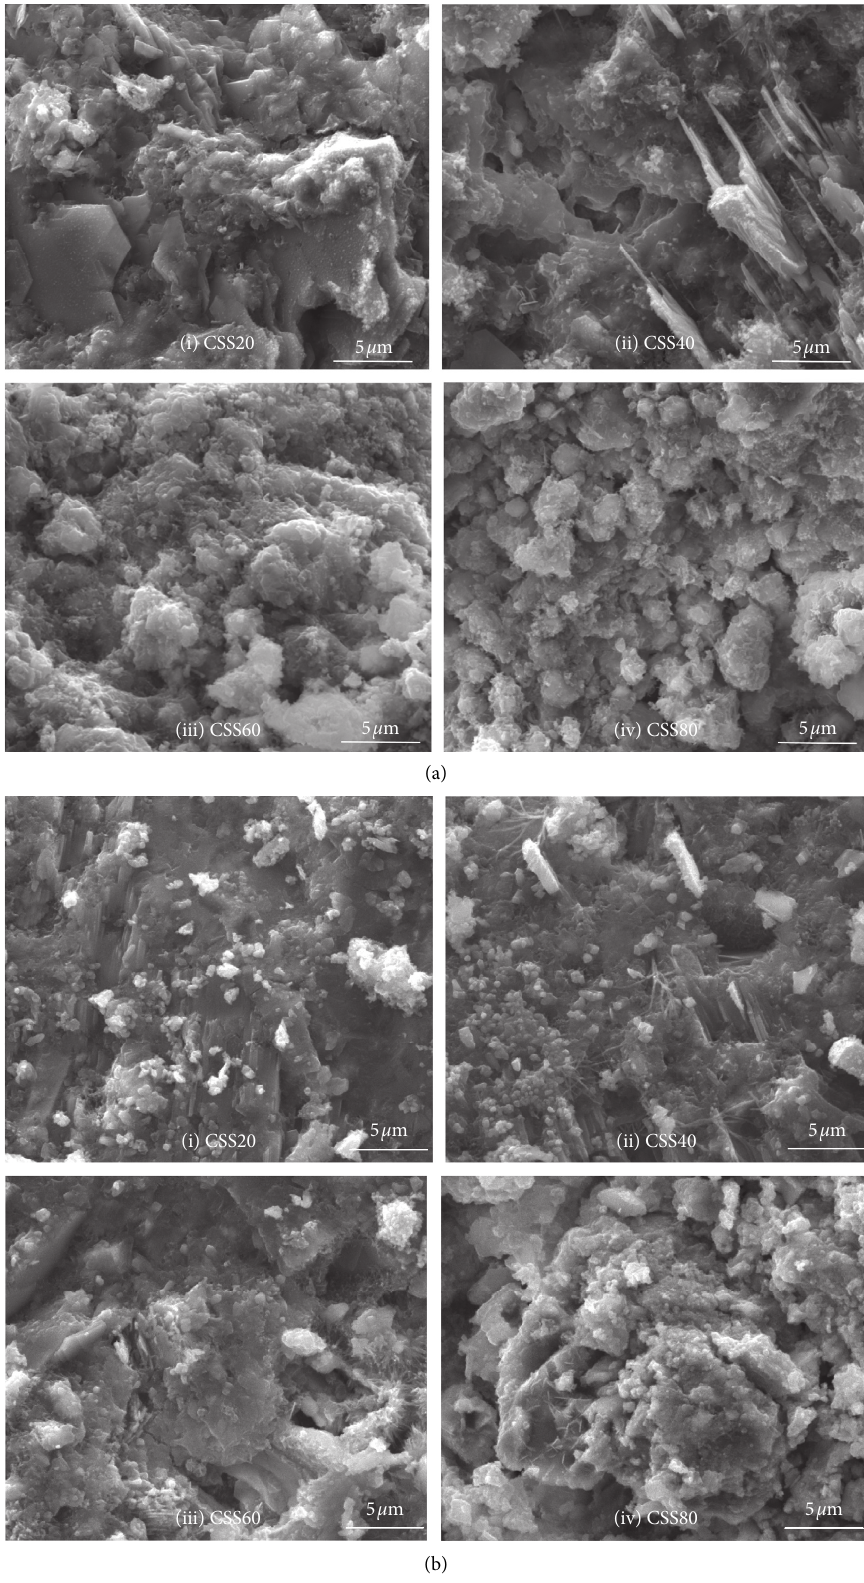
Figure 8: Morphology of blended cement containing different amounts of steel slag powder. (a) 3d. (b)